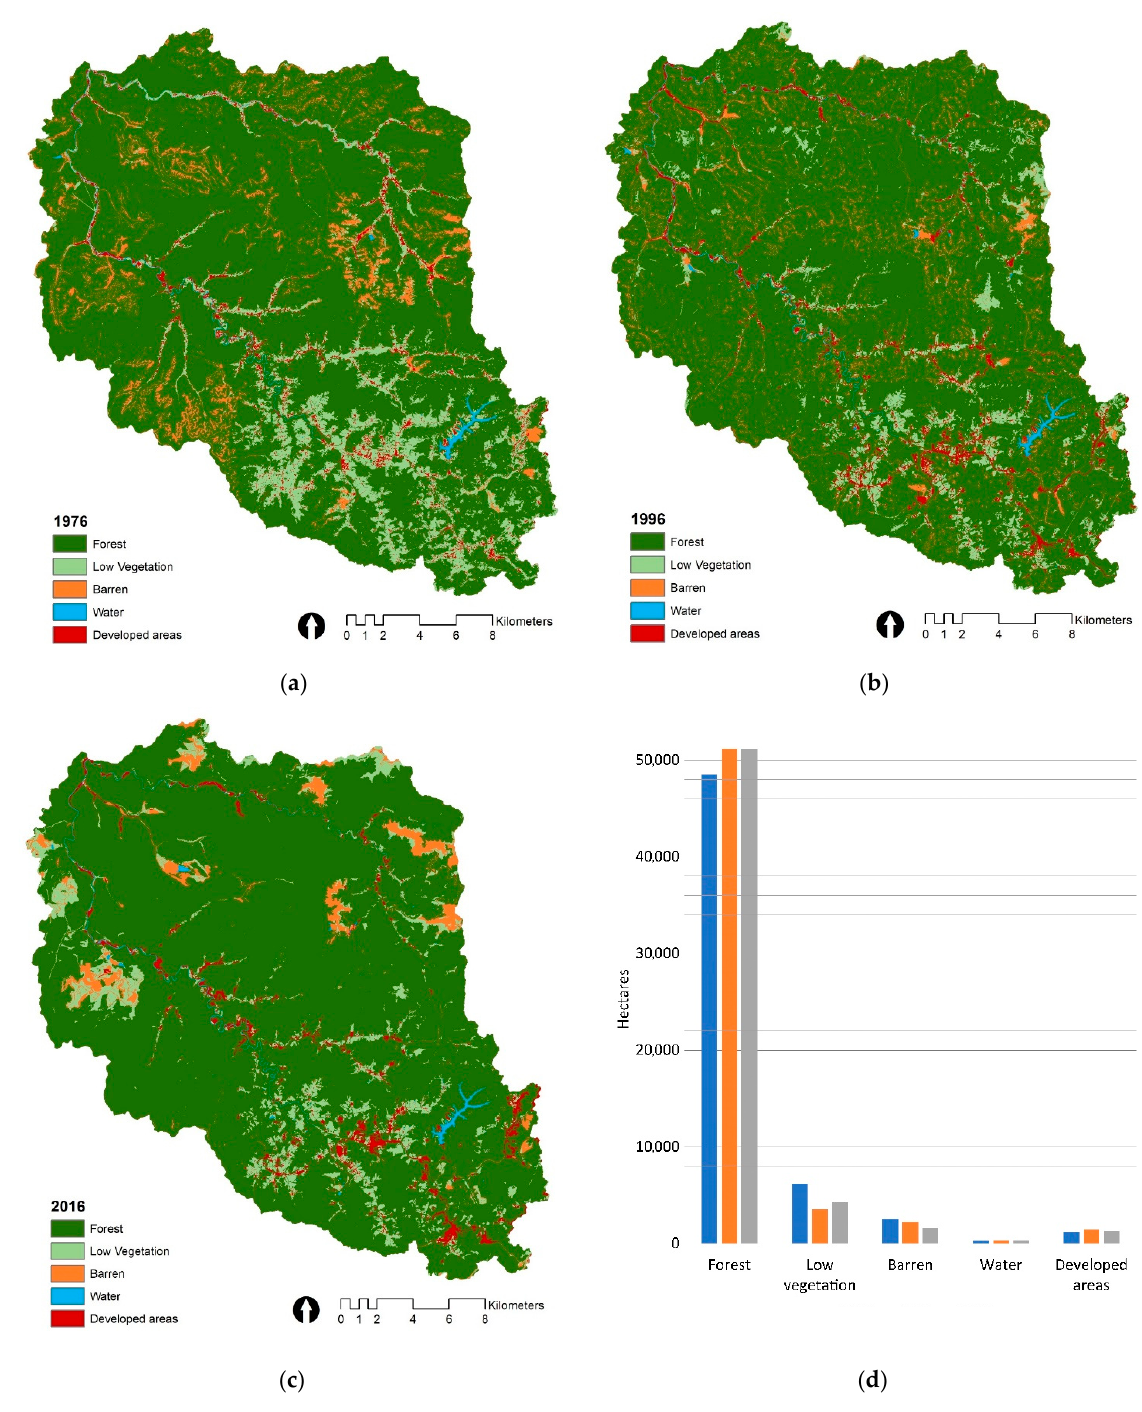
Figure 7. The three land cover classifications after the post-processing phase: ( a ) 1976; ( b ) 1996; ( c ) 2016; ( d ) land covers quantities plot for 1976, 1996, 2016. Values are in hectares.